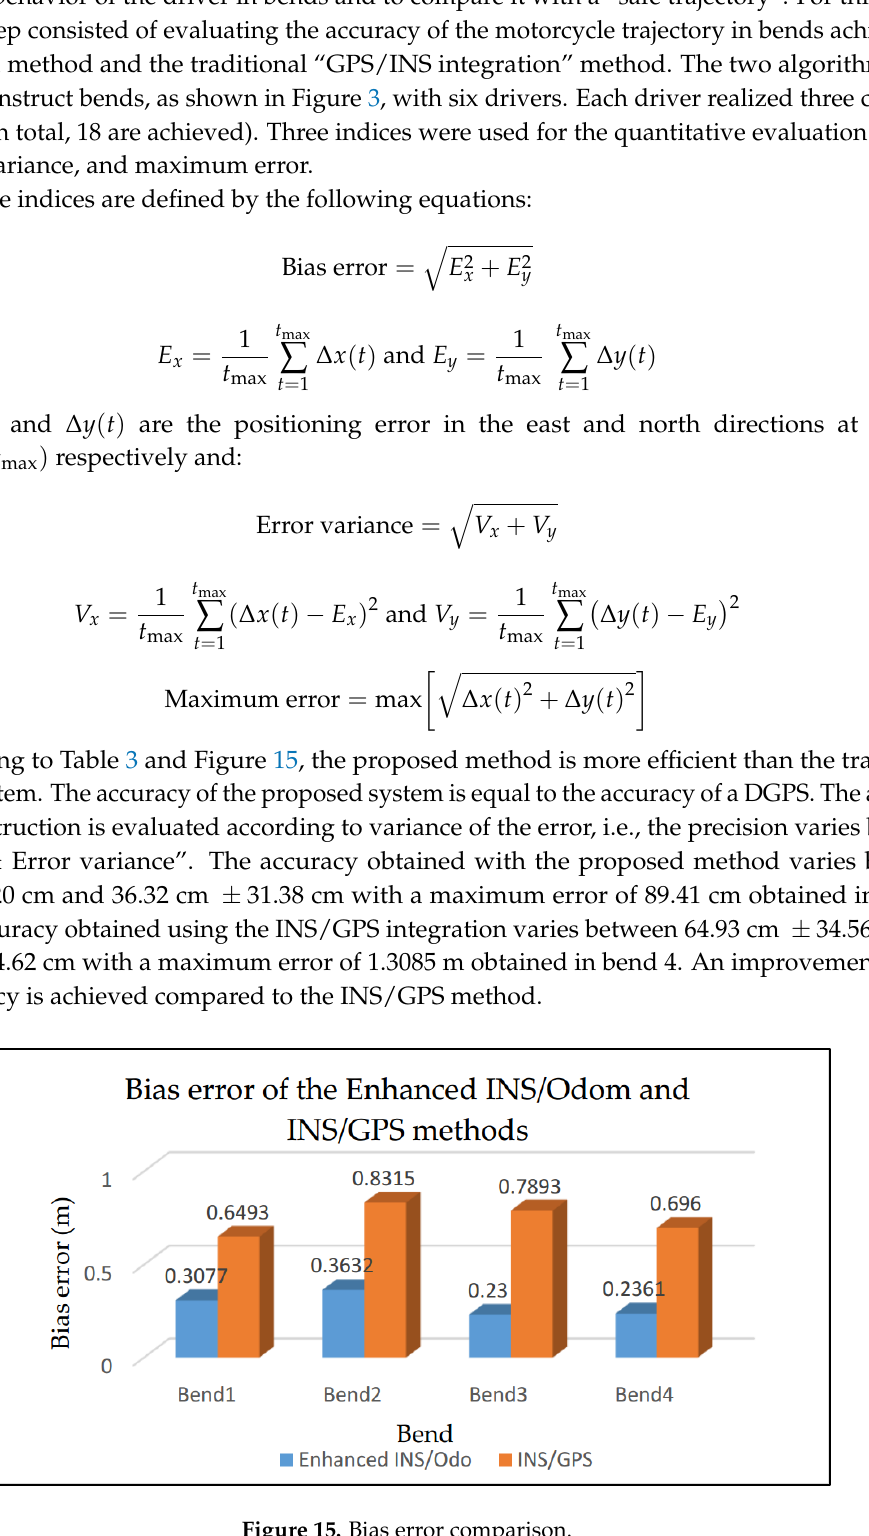
Figure 15. Bias error comparison.